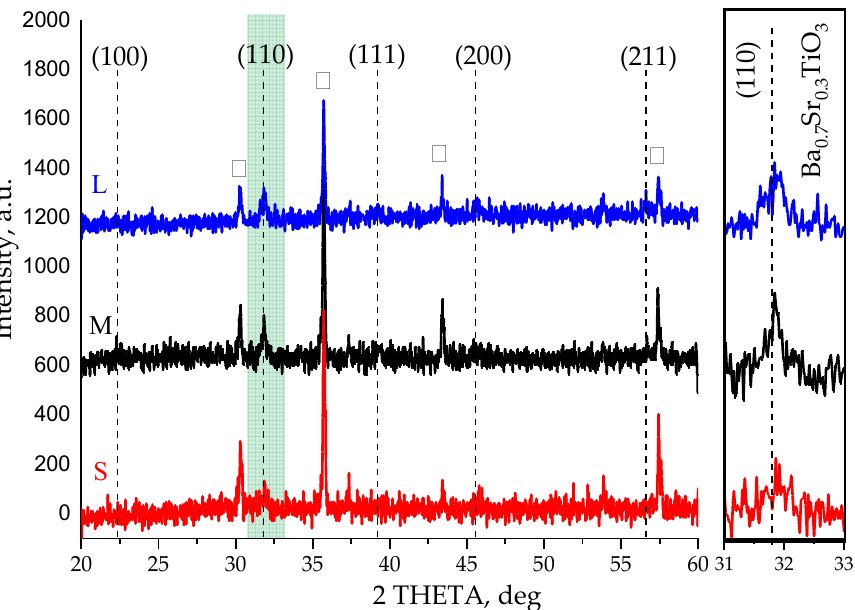
Figure 3. Comparative XRD patterns of ferrite matrices with different FE inclusion ratios. Holes diameter: S–0.25 mm, M–0.4 mm, L–0.6 mm.